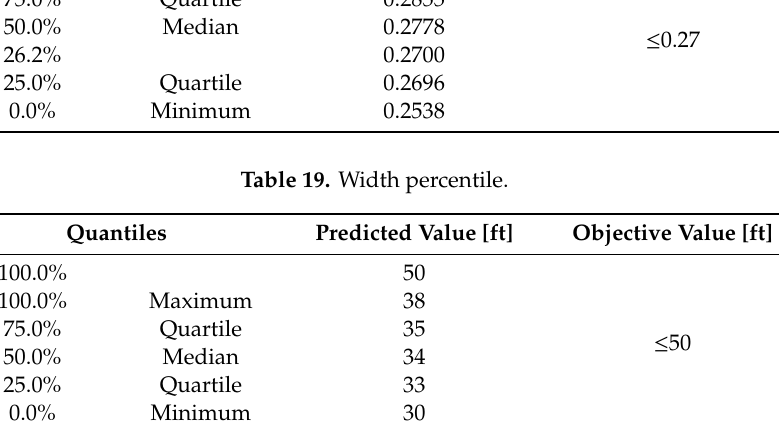
Table 18. Horsepower to weight ratio (P/W) percentile.